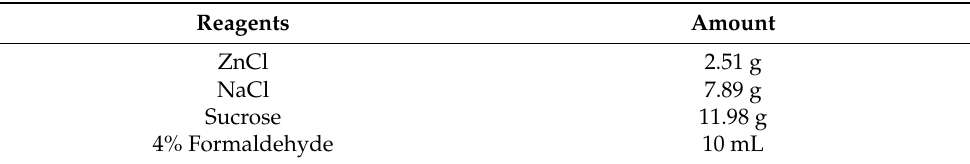
Table 3. Reagents used to make 1 L of